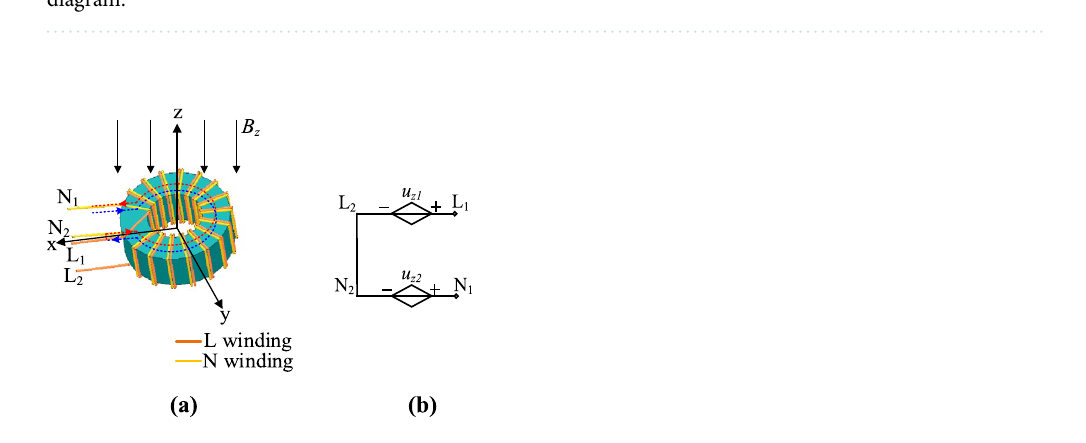
Figure 4. CM choke subjected to the magnetic field in y-direction: ( a ) schematic diagram; ( b ) equivalent circuit diagram.